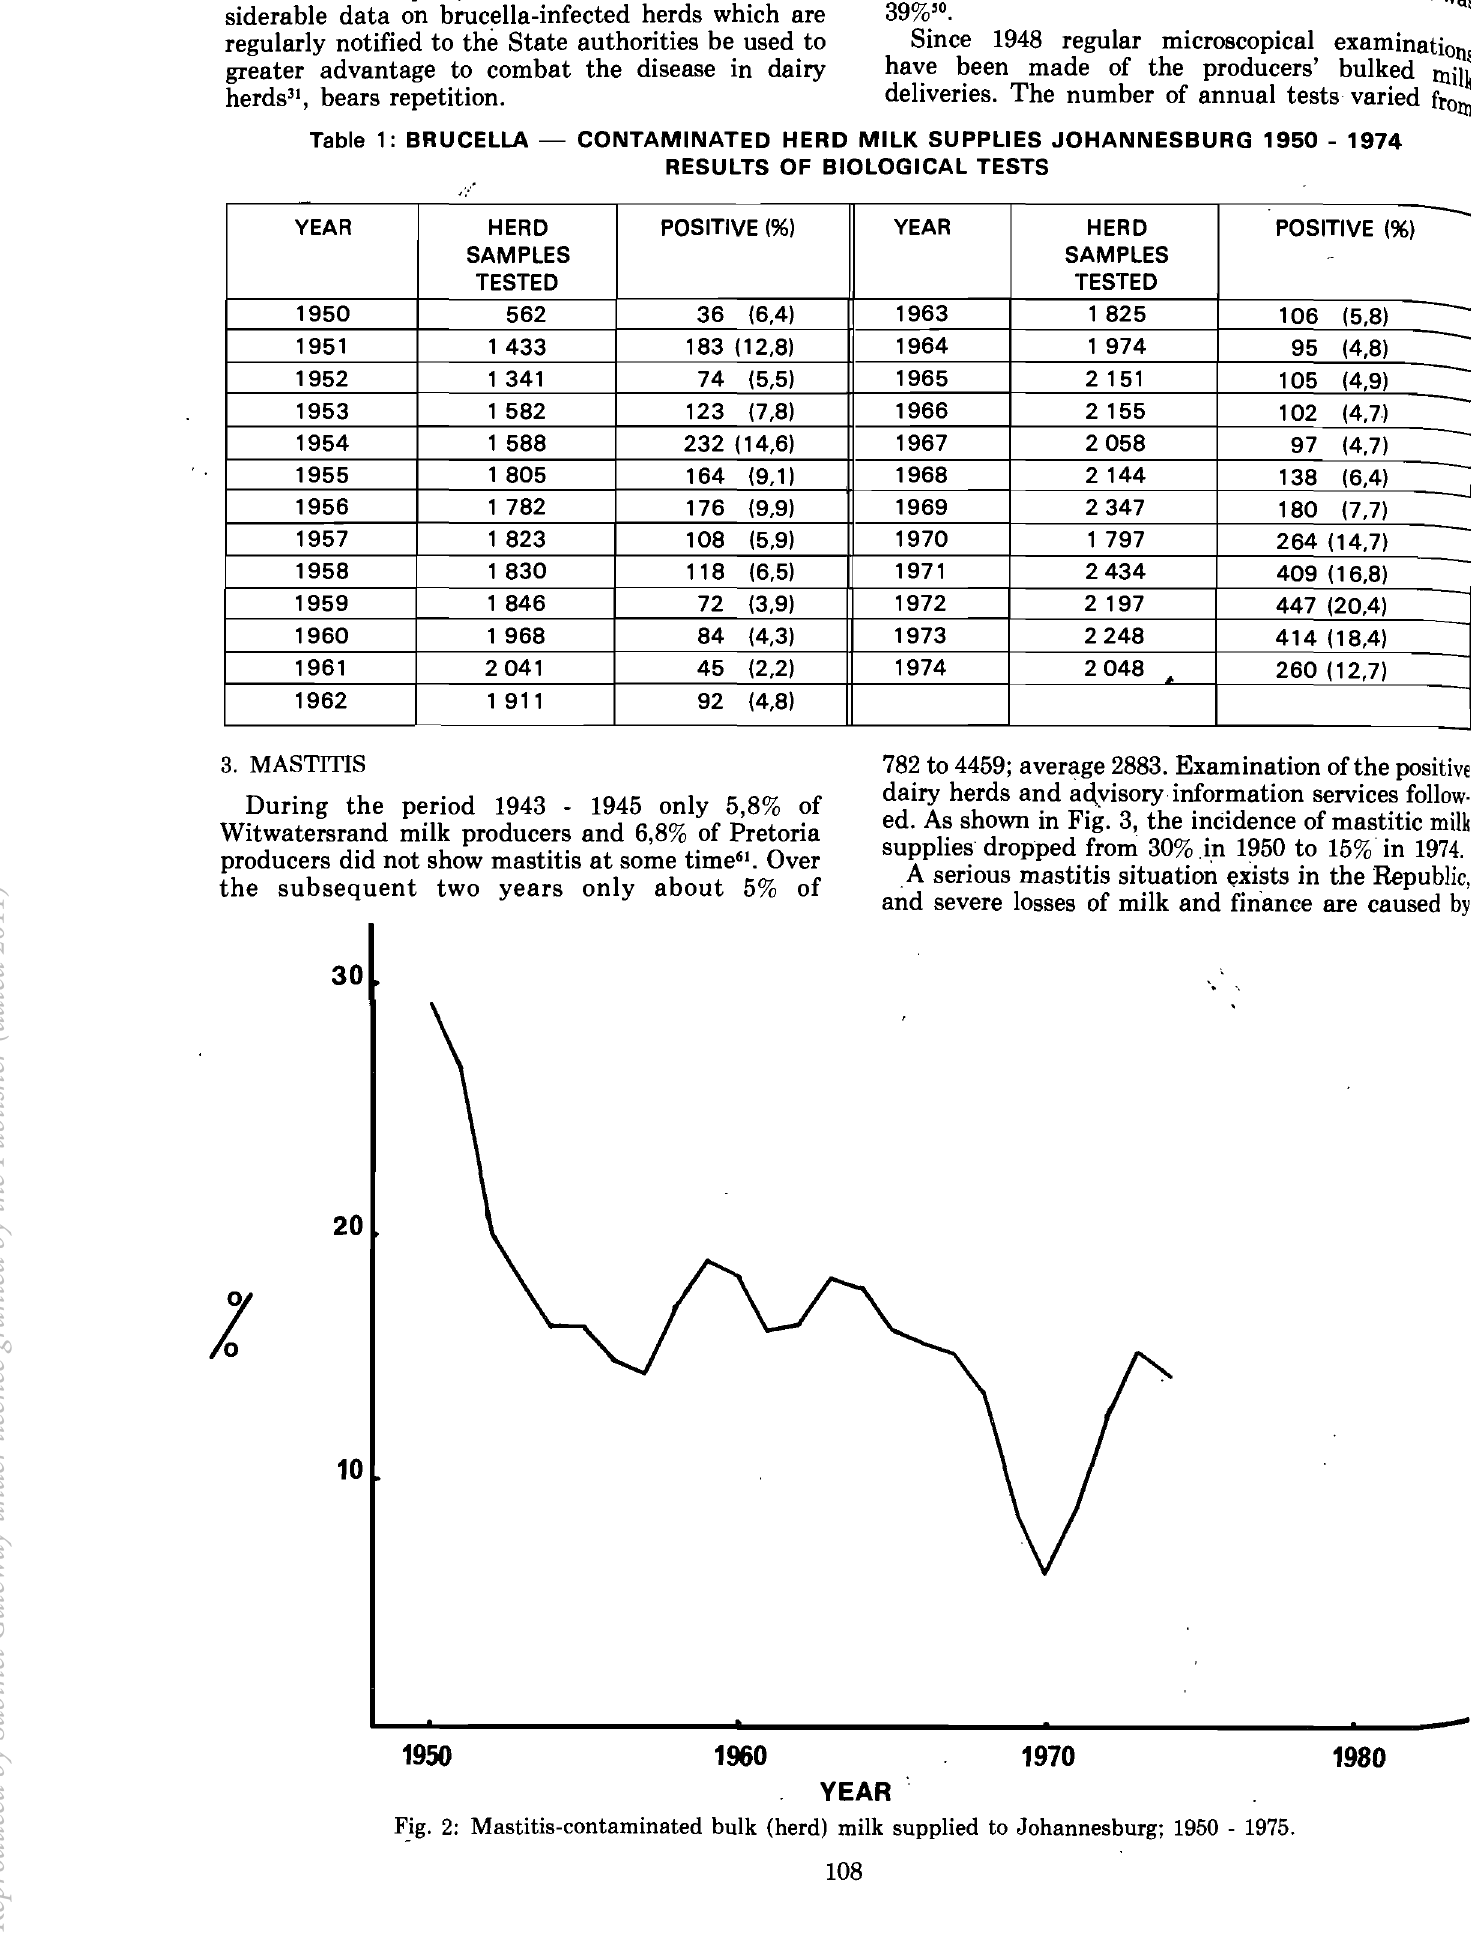
F}g. 2: Mastitis-contaminated bulk (herd) milk supplied to Johannesburg; 1950 - 1975.